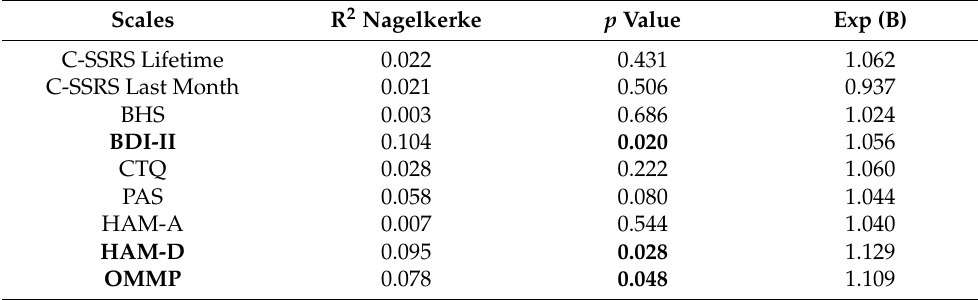
Table 3. Association between psychometric scales and predictive risk of incurring a new